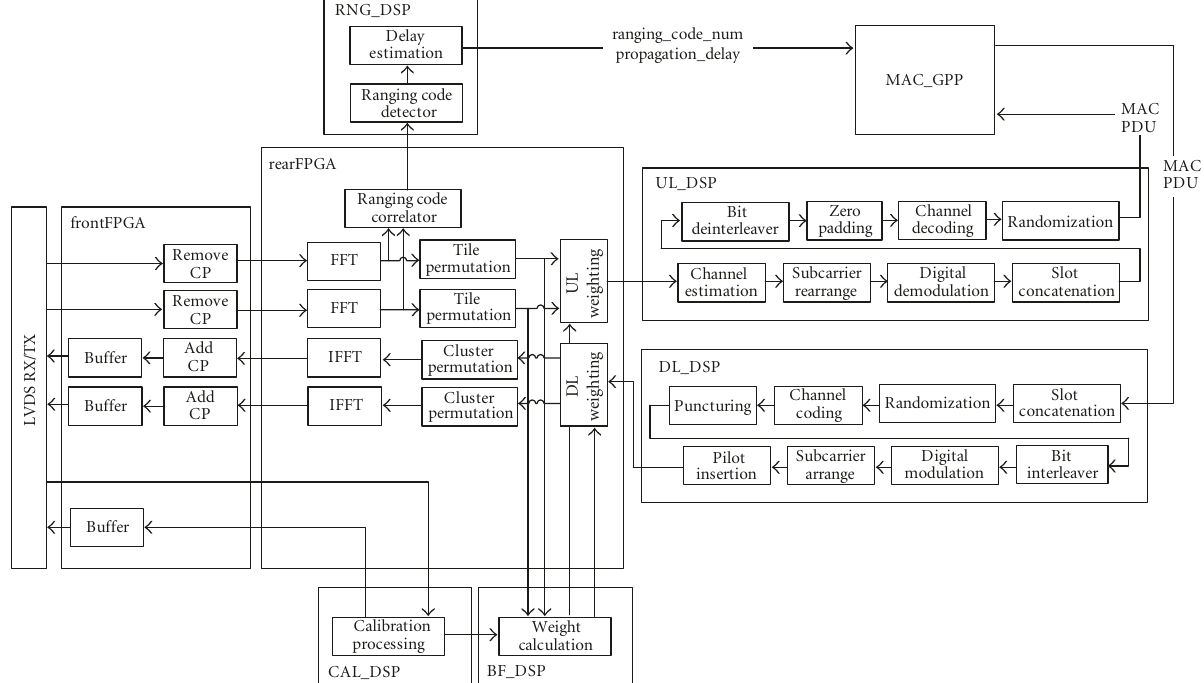
Figure 6: Functional allocation for baseband modem of the SA system.